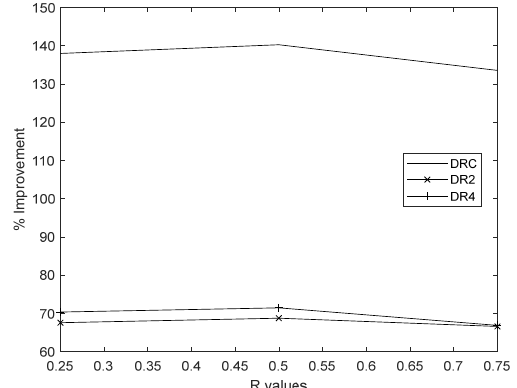
Fig. 2. Percentage Improvement versus number of jobs Fig. 3. Percentage Improvement versus R values